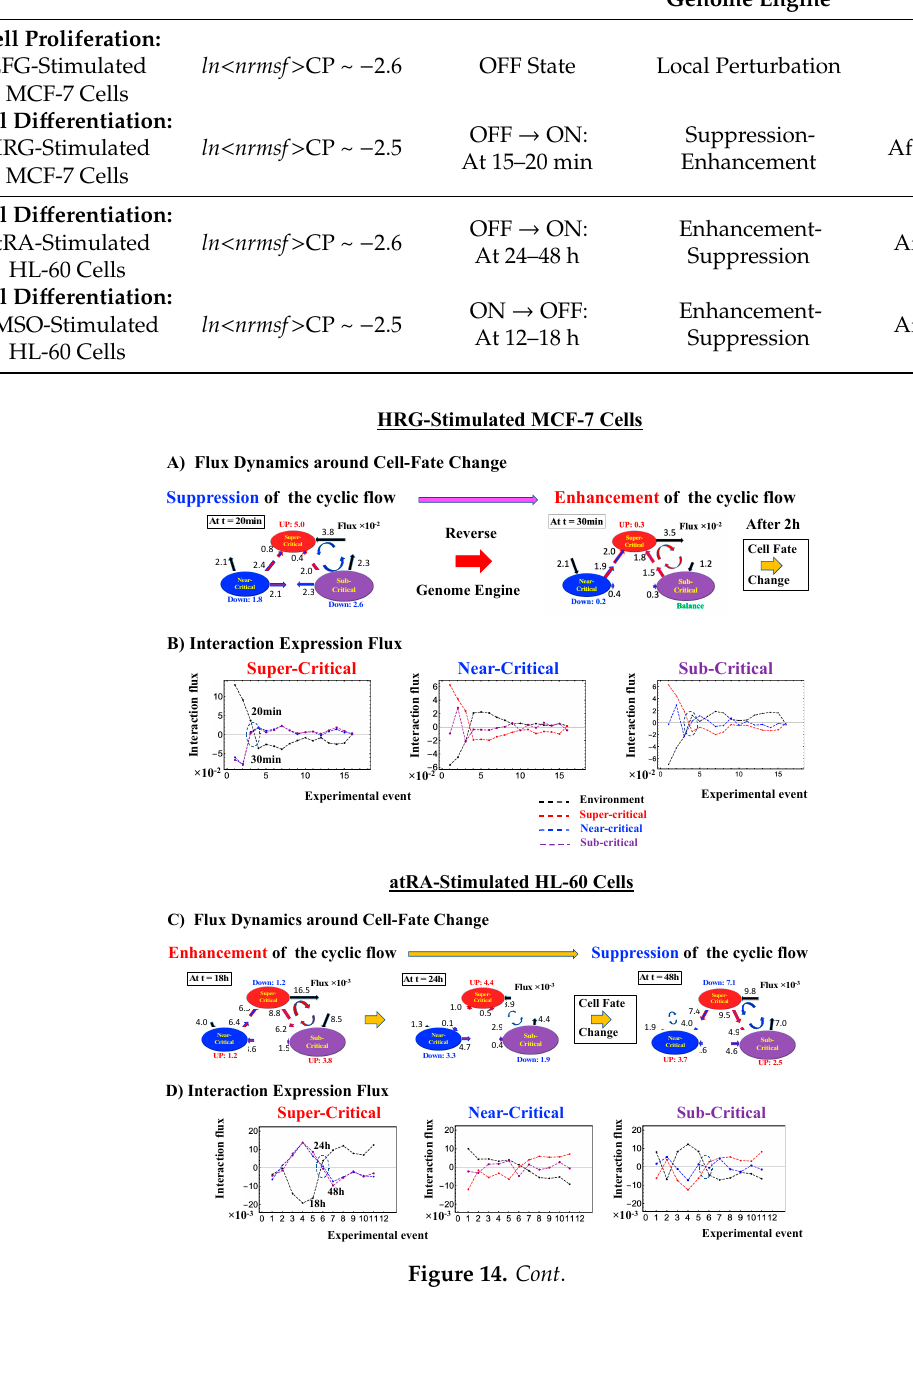
Table 4. Cell population: state change in the CP associated with coherent perturbation of the genome engine. Table provides summary of when and how the state change in the CP with perturbation of the genome engine occurs EGF- and HRG-stimulated MCF-7 cells, DMSO- and atRA-stimulated HL-60 cells (from top to bottom row, respectively). * Cell fate-guiding state change occurs in the CP. ** Refer to a time lag mechanism in [10]. Coherent Cell-Fate State Change * in Biological Perturbation of Location of the CP Change the CP Regulation Genome Engine